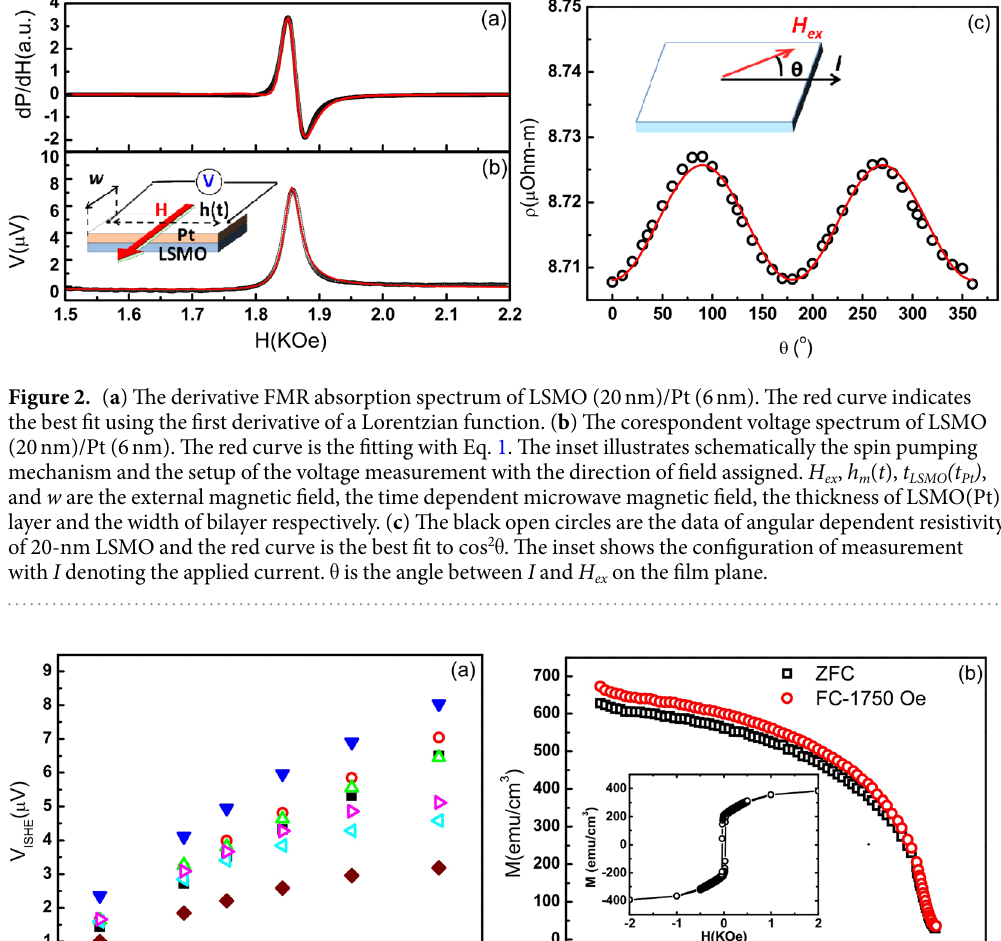
symmetric FMR-induced ISHE voltage ( V ISHE ) and the asymmetric term V AHE from the anomalous Hall effect (AHE), as described by = where Δ H and H R are the linewidth and the resonant field respectively. The phase of V AHE originated from the interaction between the microwave electric oscillation and the magnetization of the FM layer has an intrinsic π /2-difference with V ISHE at resonant condition, which is the main cause for the asymmetric part of the voltage spectrum. The value of V ISHE is shown in Fig. 3a with the variation of excitation microwave power from 20 mW to 100 mW for the entire series of LSMO/Pt( t Pt ) bilayers. A simplified equation o is the spin current density, h is adopted, where j m the microwave magnetic field and M eff the effective magnetiza- s tion. Accordingly, j so should increase linearly with the square of h m , which yields a leaner dependence of V ISHE vs. microwave power. However, for samples with thicker Pt, V ISHE saturates at high power due to the heating effect from high microwave power 27 . To demonstrate this, Fig. 3b plots the temperature dependent field-cooled (FC) and zero-field-cooled (ZFC) magnetization for LSMO(20 nm)/Pt(6 nm), showing the magnetization at 300 K is very sensitive to temperature change. Hence, the microwave heating would substantially decrease the magnetiza- tion as well as ISHE voltage. In this work, we focus on the linear microwave power regime ( < 60 mW) where the theory applies.